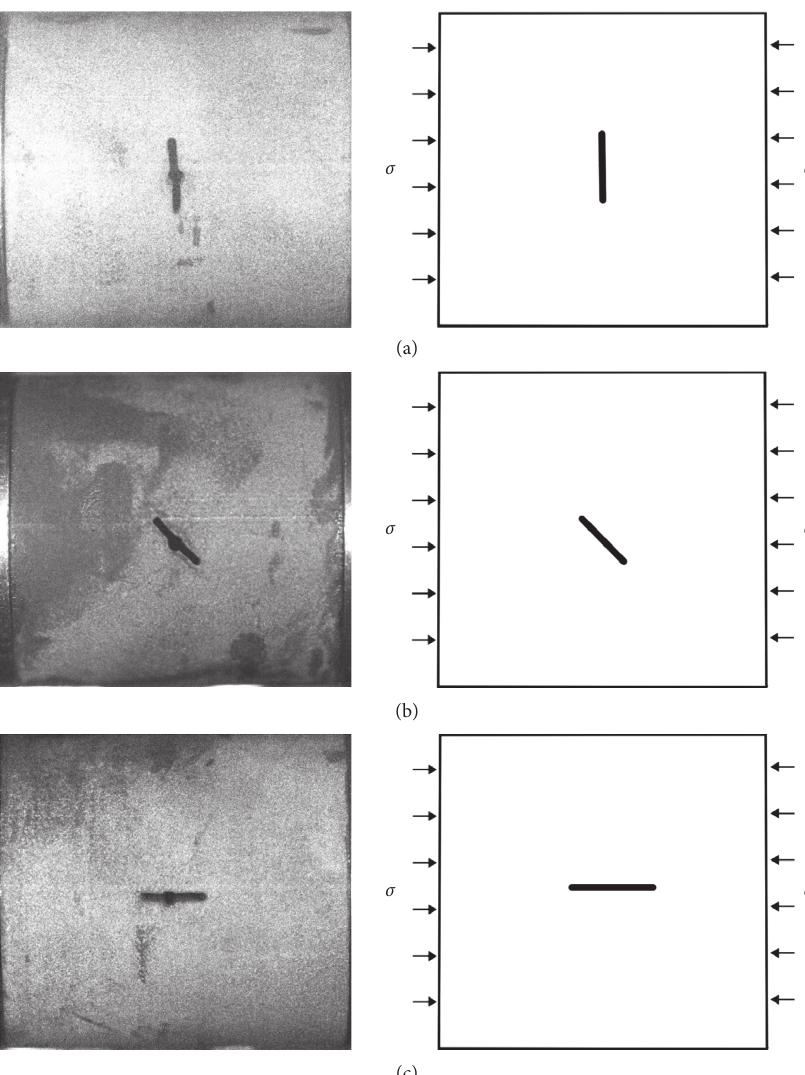
Figure 2: Loading methods on specimens with prefabricated fractures at (a) 0 ° , (b) 45 ° , and (c) 90 ° .